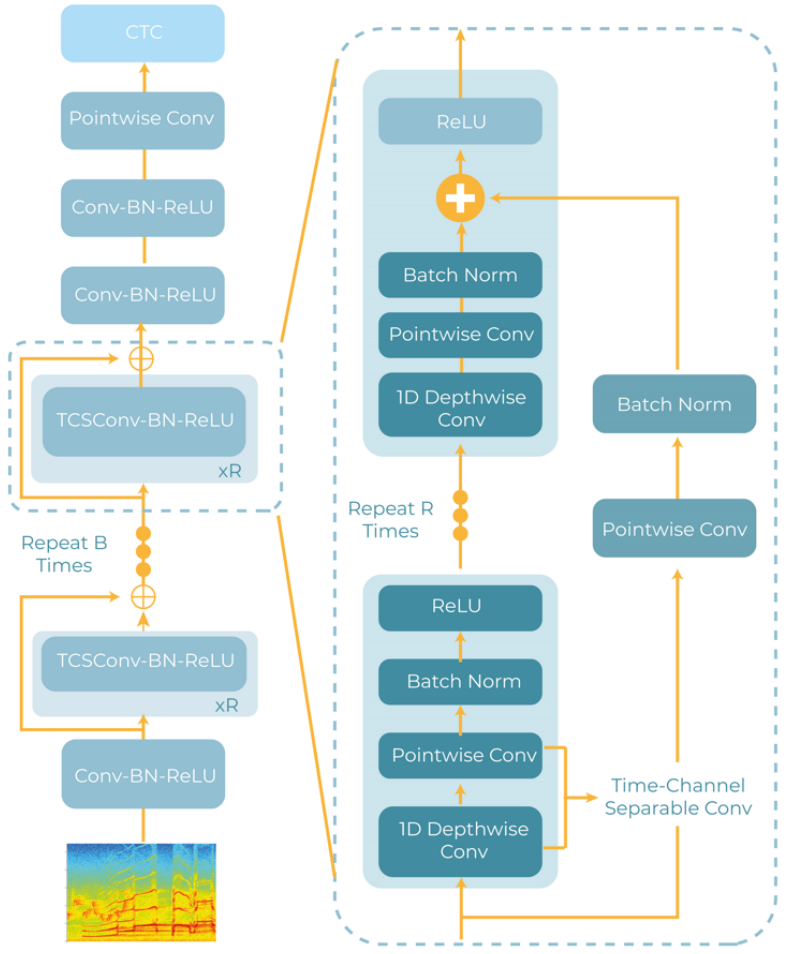
Figure 2. Architecture of the Quartznet ASR model of NVIDIA. The input spectrogram of the audio signal is first processed by a 1D CNN layer and then fed into a series of five groups of blocks. Each group is composed of three blocks with residual connection between them in the Q15 × 5 architecture and one block for the Q5 × 5 architecture. Blocks are formed by a module composed of a Time-Channel Separable CNN repeated five times. Finally, a sequence of 3 CNN feed the output to a trainable CTC layer. This figure is based on the one presented in